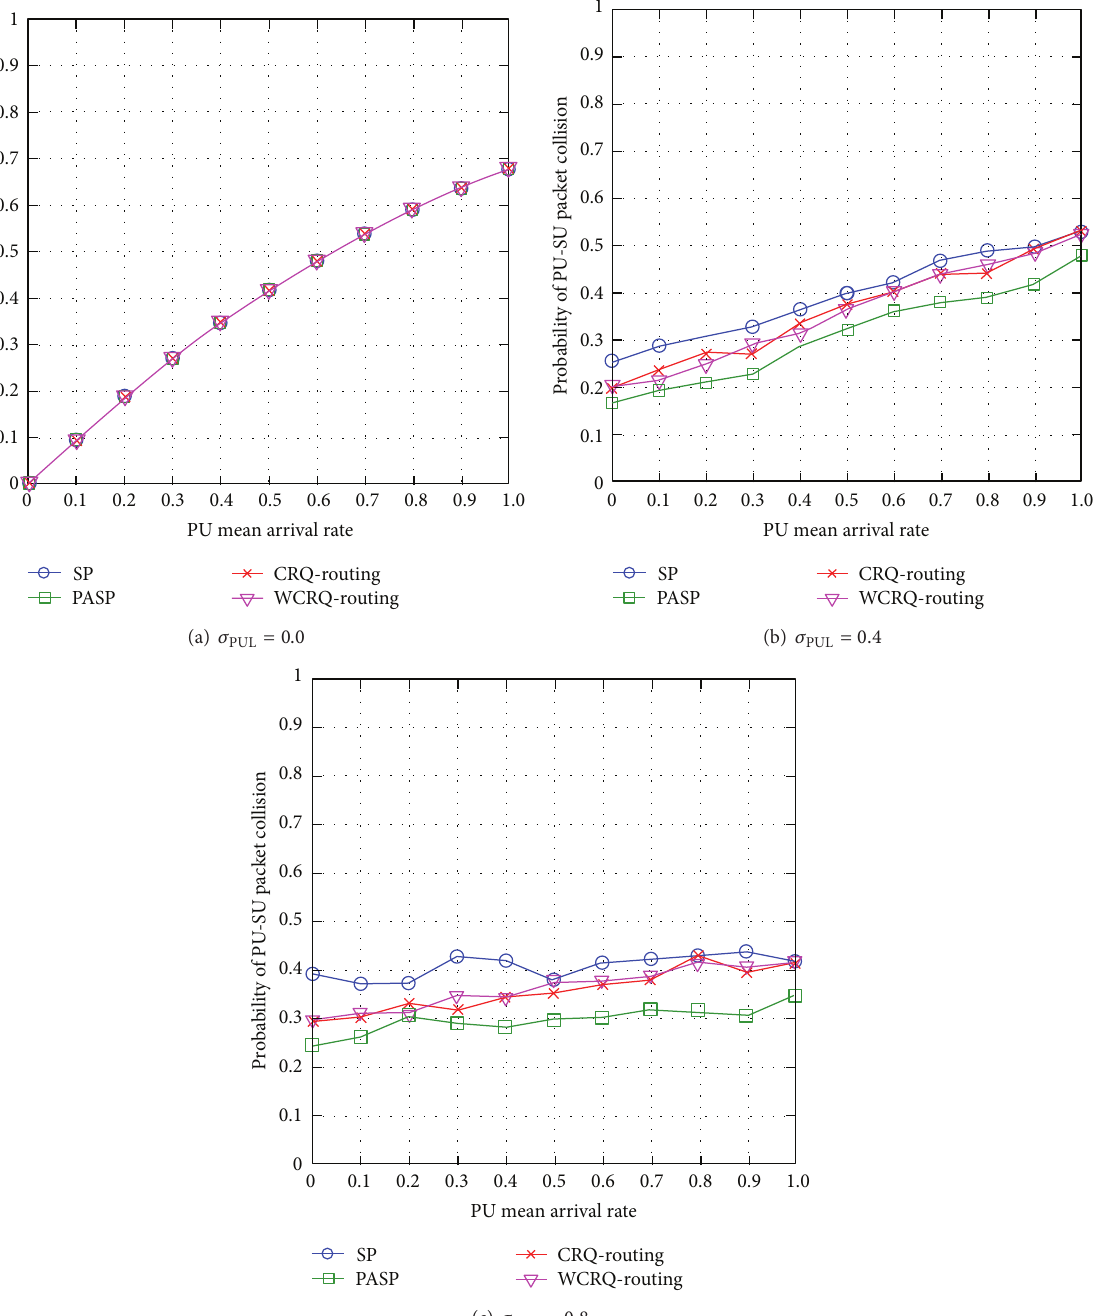
Figure 2: SUs’ interference to PUs for varying PU mean arrival rate 𝜇